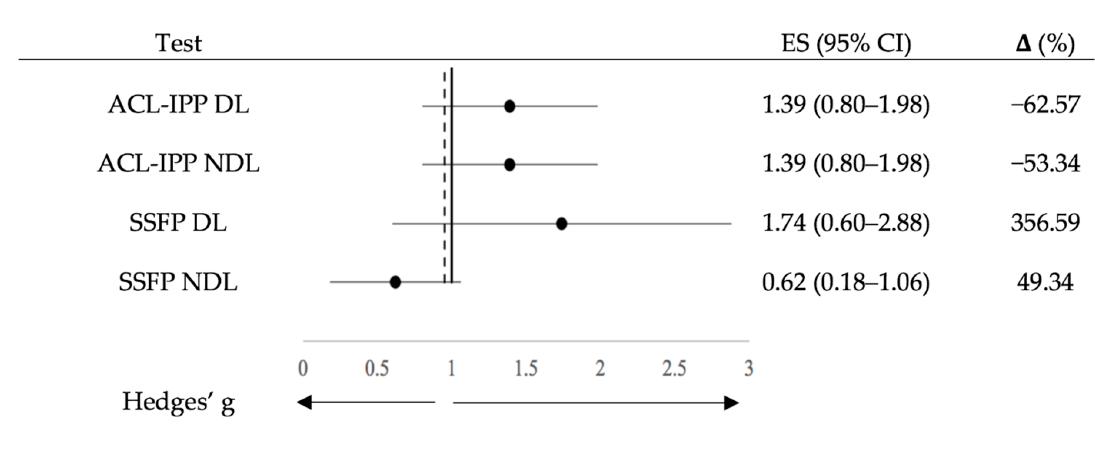
Figure 2. Effect sizes of protocols differentiated by leg dominance. Figure 2. E ff ect sizes of protocols di ff erentiated by leg